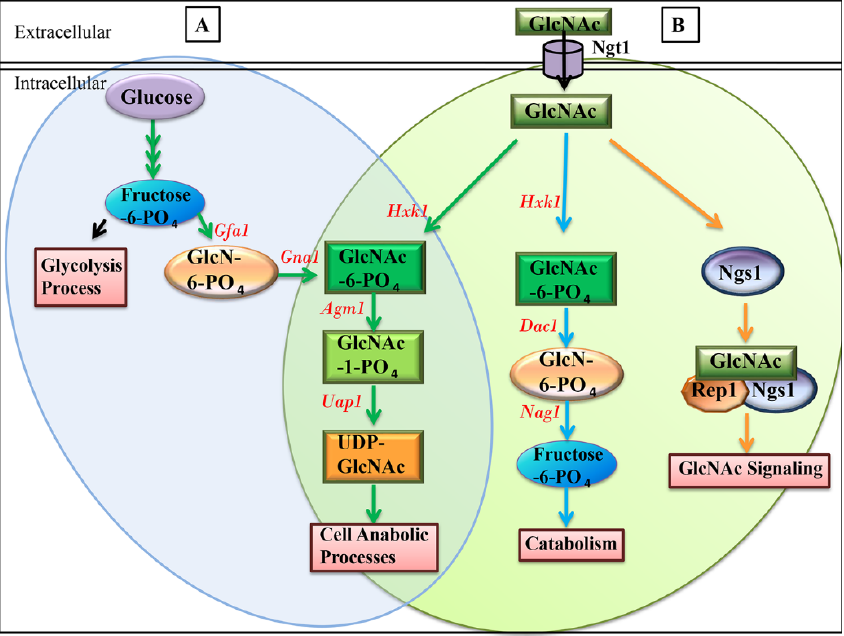
Figure 1. Direct import of external N-acetylglucosamine (GlcNAc) induces the signaling, but its metabolism is not required for GlcNAc signaling. Detection of external, non-phosphorylated GlcNAc provides sensitivity against internally synthesized GlcNAc-6-phosphate. ( A ) The internal de novo synthesized GlcNAc-6-P is utilized in the anabolic processes/functions, such as chitin synthesis, N-glycosylation, GPI-anchors, etc., and is not involved in the GlcNAc signaling pathway. De novo synthesis of GlcNAc-6-P involves sequential action of GlcN-6-P synthase (Gfa1) and GlcN-6-P acetyltransferase (Gna1) from fructose-6-P (Glycolysis). GlcNAc-6-P gets further converted to UDP-GlcNAc by the sequential action of phosphor acetylglucosamine mutase (Agm1) and UDP-GlcNAc pyrophosphorylase (Uap1) [32]. ( B ) The internalized GlcNAc through the GlcNAc specific transporter (Ngt1) can directly induce the signaling by binding to GlcNAc sensor (Ngs1). GlcNAc is also metabolized to GlcNAc-6-P by GlcNAc kinase (Hxk1), which is either catabolized using sequential action of Deacetylase (Dac1) and Deaminase (Nag1) to provide energy, or converted to UDP-GlcNAc involved in anabolic functions. The overlapping area between A and B represents the steps that are common to both the de novo pathway and imported GlcNAc pathway used for anabolic functions. Note: while steps involved in the anabolic pathways are represented with green arrows, the steps involved in the GlcNAc catabolic and GlcNAc signaling pathways are represented with blue and orange arrows, respectively .